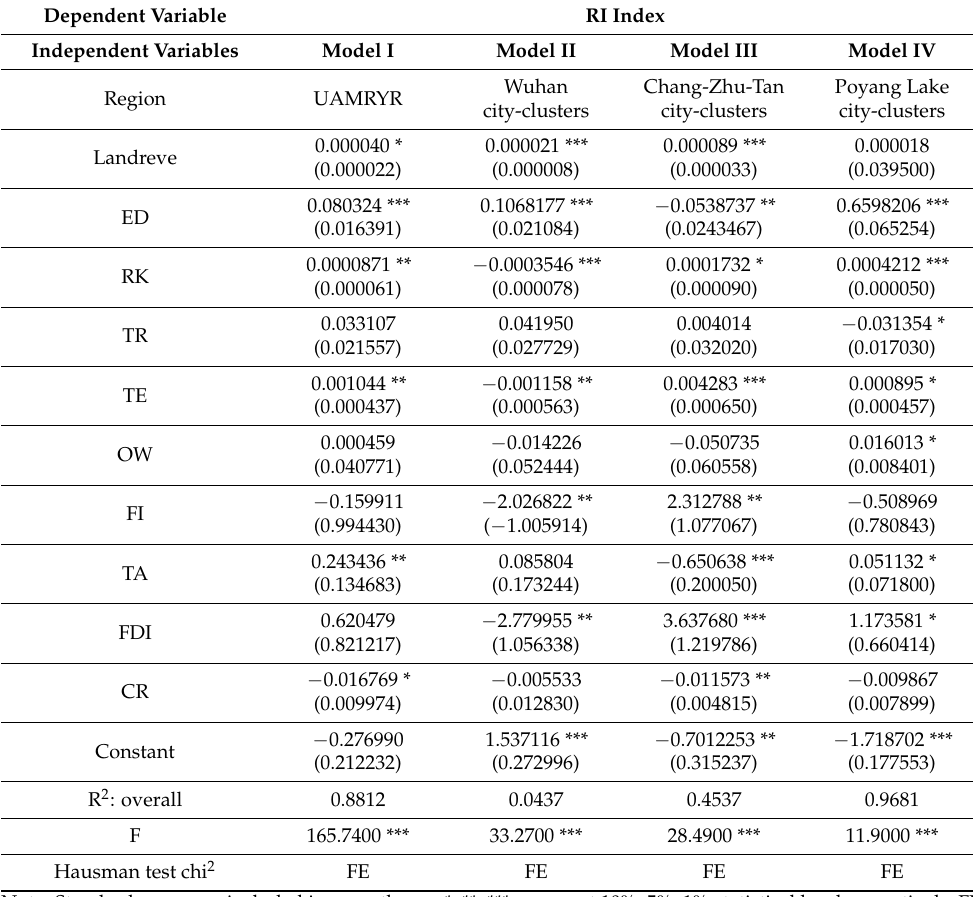
Table 2. Estimated results for Landreve as the dependent